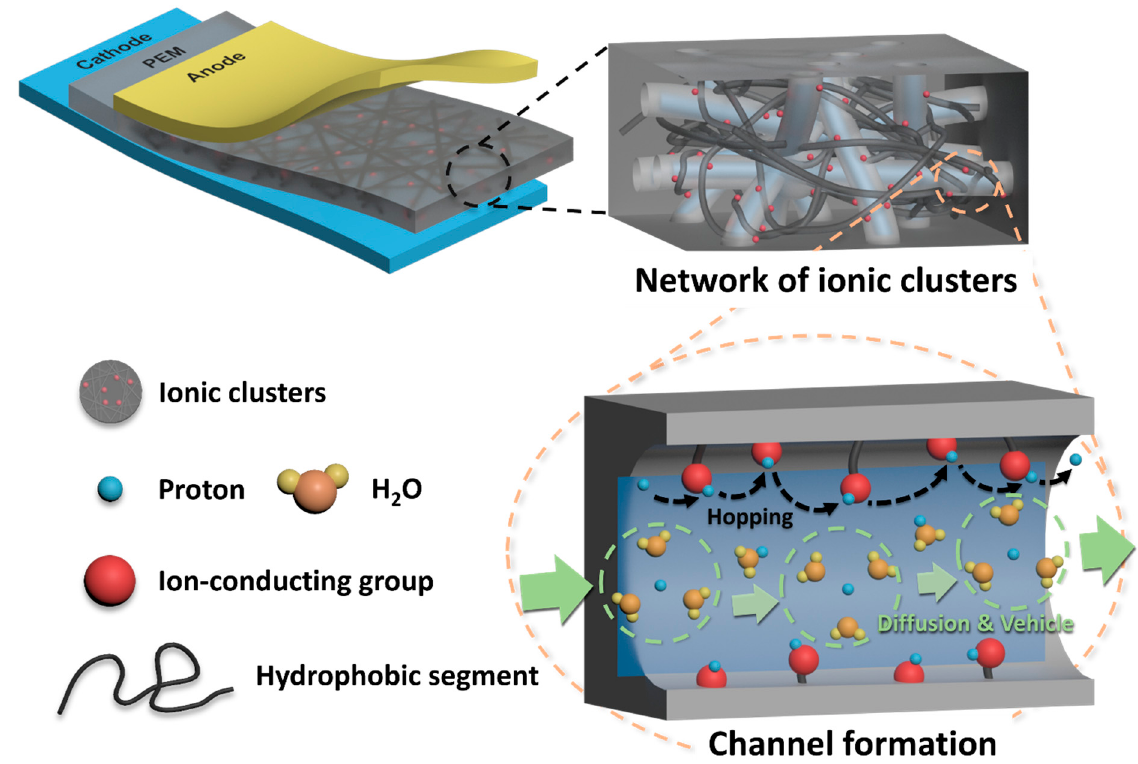
Figure 2. Schematic diagram of ionic clusters formed in polymer electrolyte membranes.